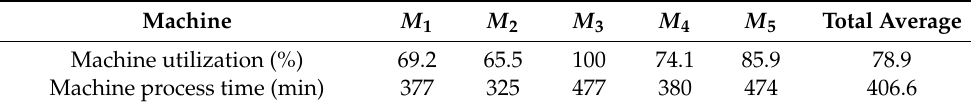
Table 8. The machine utilization and process time simulation model results.